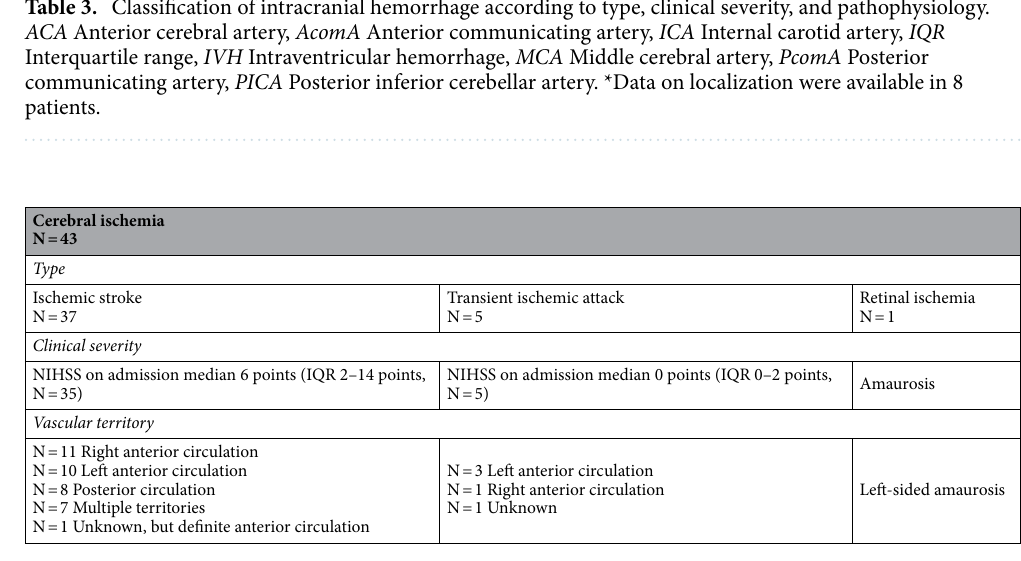
Table 4. Classification of cerebral ischemia according to type, clinical severity, and vascular territory. NIHSS National Institutes of Health stroke